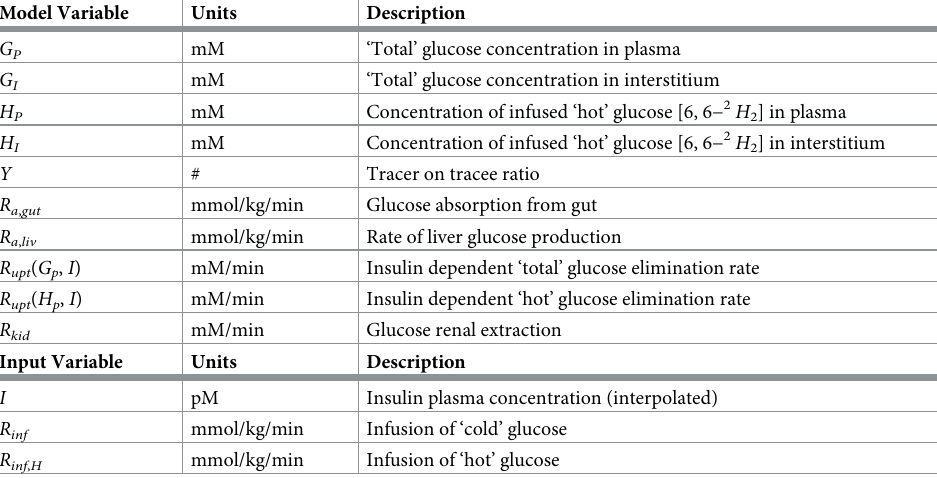
Table 2. Model variables and input variables (external inputs) along with their unit of measurement and description. Model Variable